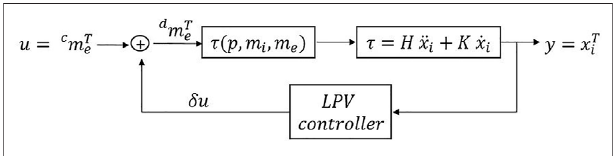
FIGURE2| Controlscheme. δ u isthelinearizedinputcomputedwiththe LPV controller and c m T e and d m T e are the current and desired EPM magnetic moment,